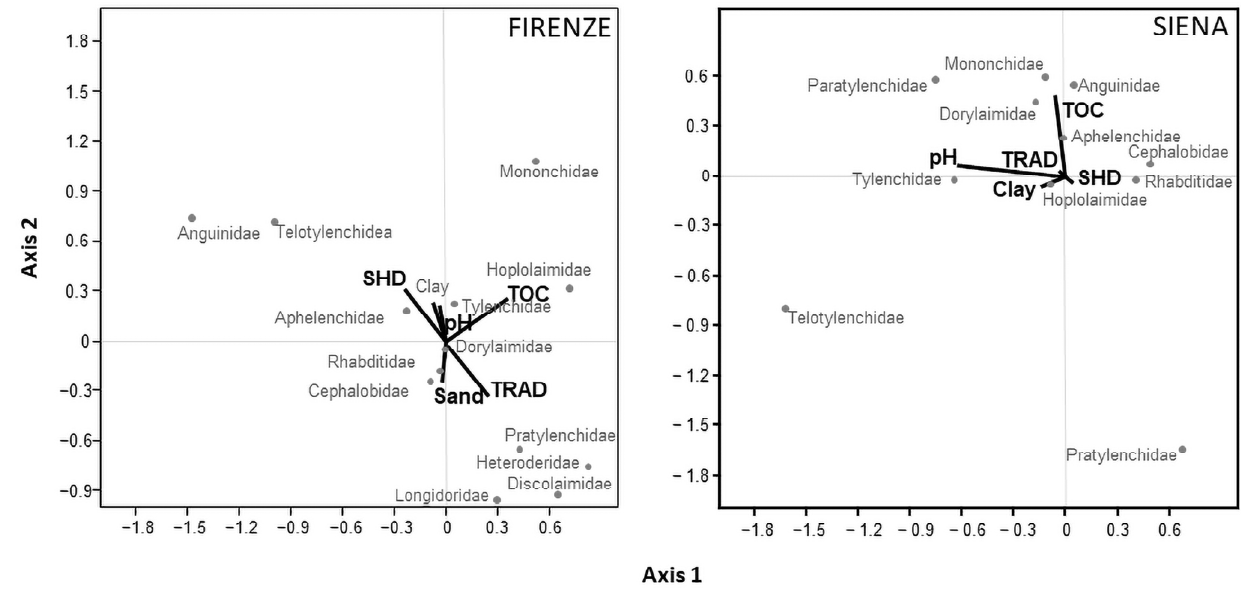
Figure 3. Scatter plots of CCA between soil properties and nematode taxa abundance. Firenze, percentage of variance explained was 37.50% for axis 2 ( p < 0.04), and no significance for axis 1. Siena, percentage of variance was 79.77% for axis 1 ( p < 0.02) and 24.05% for axis 2 ( p < 0.03).